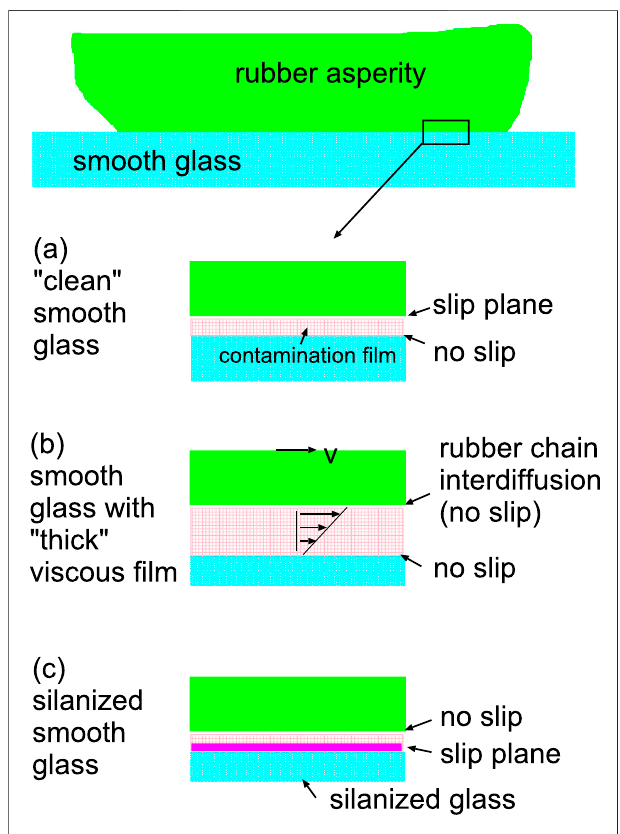
FIGURE 2 | The contribution to the friction from the area of real contact dependsonsurfaceenergies,contamination fi lmsandslip(orshear)planes.In (A) athin strongly bound contamination fi lmoccur on thesubstrate surface. In (B) a thicker contamination fi lm occur, e.g. due to transfer of molecules from the rubber tothe glass surface. In (C) the glass surface is silanized which may result in slip between the contamination fi lm and the silanized glass surface